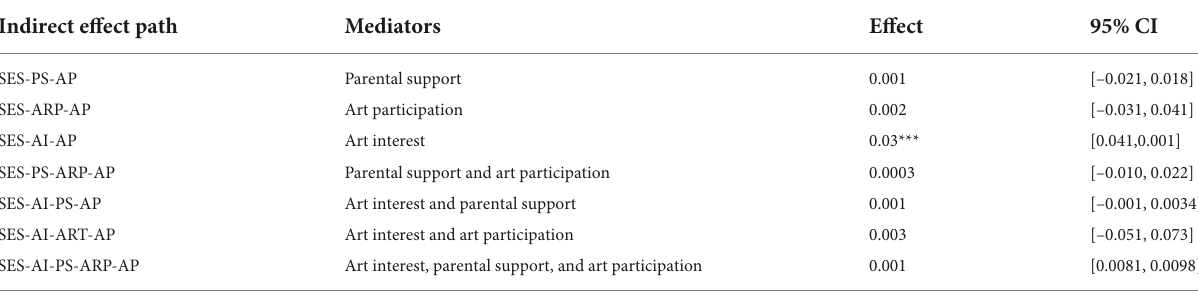
TABLE 4 Direct and indirect